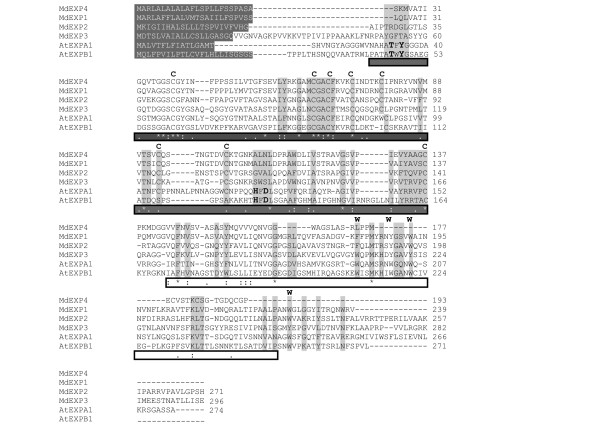
Alignment of the amino acid sequence of the Micrasterias denticulata expansin-resembling proteins Alignment of the amino acid sequence of the M. denticulata expansin-resembling proteins MdEXP2, MdEXP1, MdEXP4, and MdEXP3 with the Arabidopsis thaliana EXPA1 [NP_001117573] and EXPB1 [NP_179668]. The C-terminal extension of MdEXP2 is omitted (see Additional file 11). Dark-shaded white characters represent N-terminal sorting signals. Dark gray and white boxes below the alignment indicate the expansin domains 1 and 2, respectively. Conserved Cys (C) and Trp (W) residues are indicated above the alignment. The key residues of the GH45 catalytic site that are conserved in domain 1 of the EXPA and EXPB expansin families are shown in bold. Conserved expansin residues and motifs are lightly shaded. Asterisks mark identical residues; colons and periods indicate full conservation of strong and weak groups, respectively.